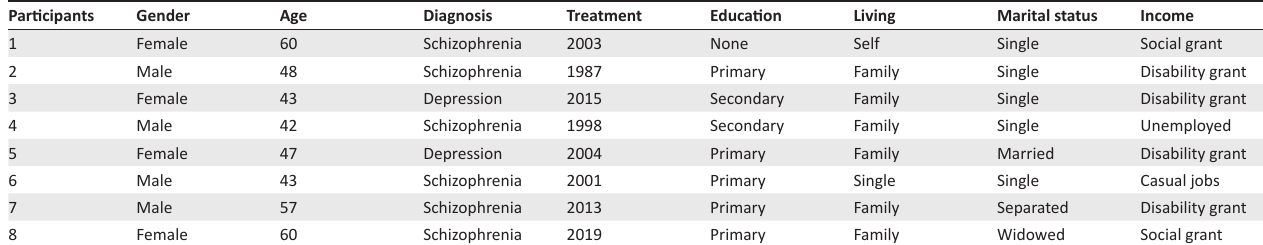
TABLE 1: Participant